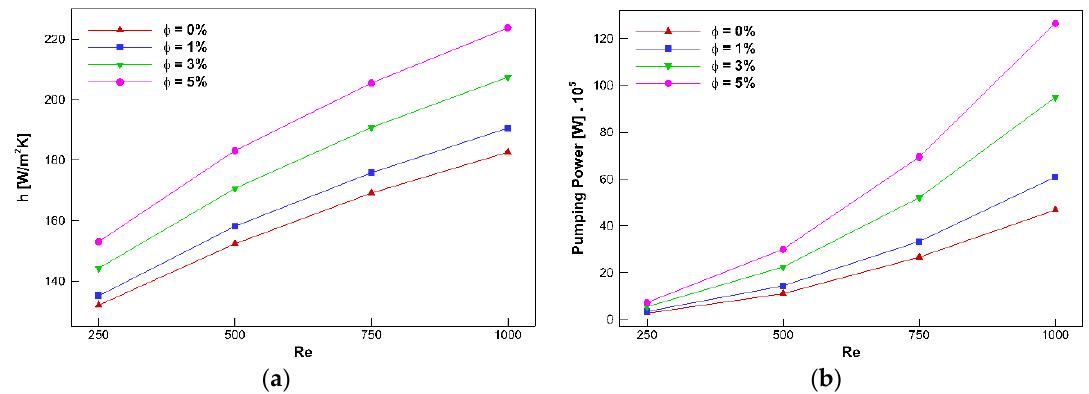
Figure 12. Convective HTC ( a ) and pumping power ( b ) versus Reynolds number for concentrations from 0% to 5% for the channel with a H = 45 mm and D = 22.5 mm.